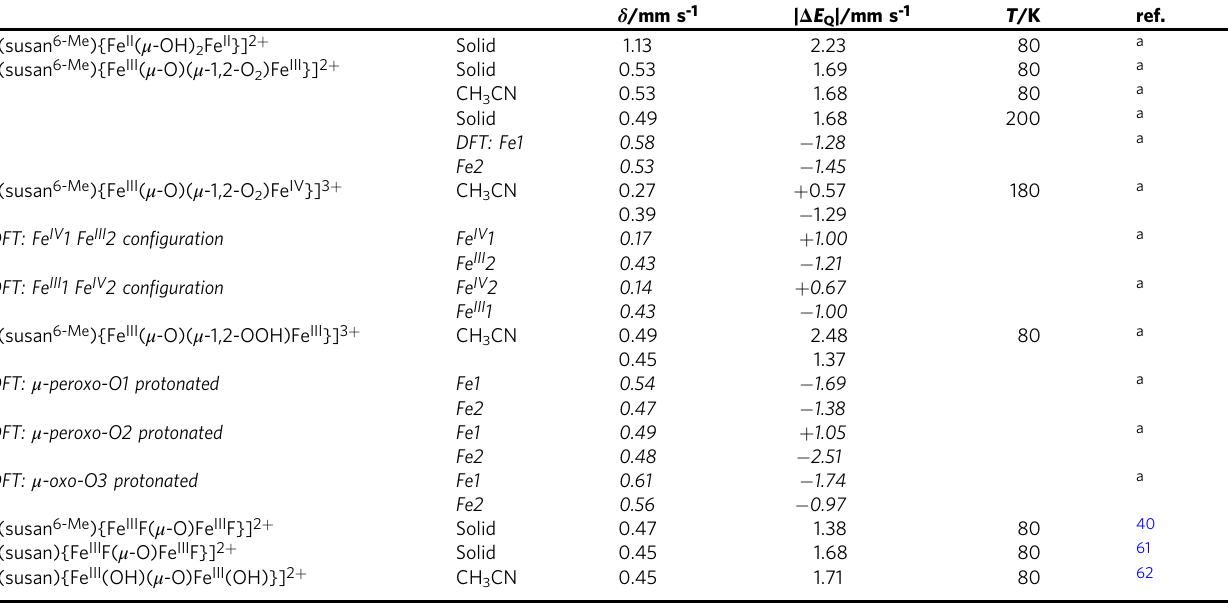
a This work Quadrupole splittings provided without a sign represent absolute values| Δ E Q |obtained from zero- fi eld Mössbauer spectra. The signs provided for [(susan 6-Me ){Fe III ( μ -O)( μ -1,2-O 2 )Fe IV }] 3 + were extracted from fi ts to the magnetic Mössbauer spectra, while signs provided for DFT-calculated values arise from the DFT calculations. Atom labeling scheme related to Fig. 2a.